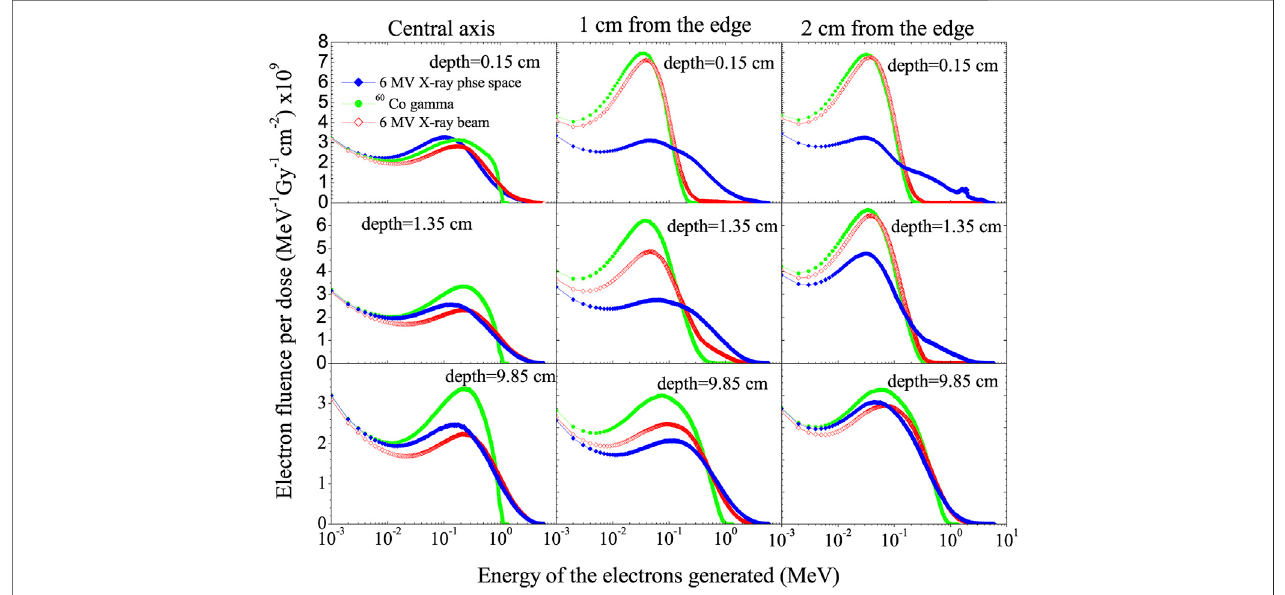
FIGURE7| Comparisonoftheelectron fl uencenormalizedtotheabsorbeddosewithinthevoxelobtainedforthephasespace,a6 MVX-raypointsource,andthe 60 Co gamma as a function of energy of the electrons generated for the 4.5 × 4.5 cm 2 fi eld at three OADs and water depths.